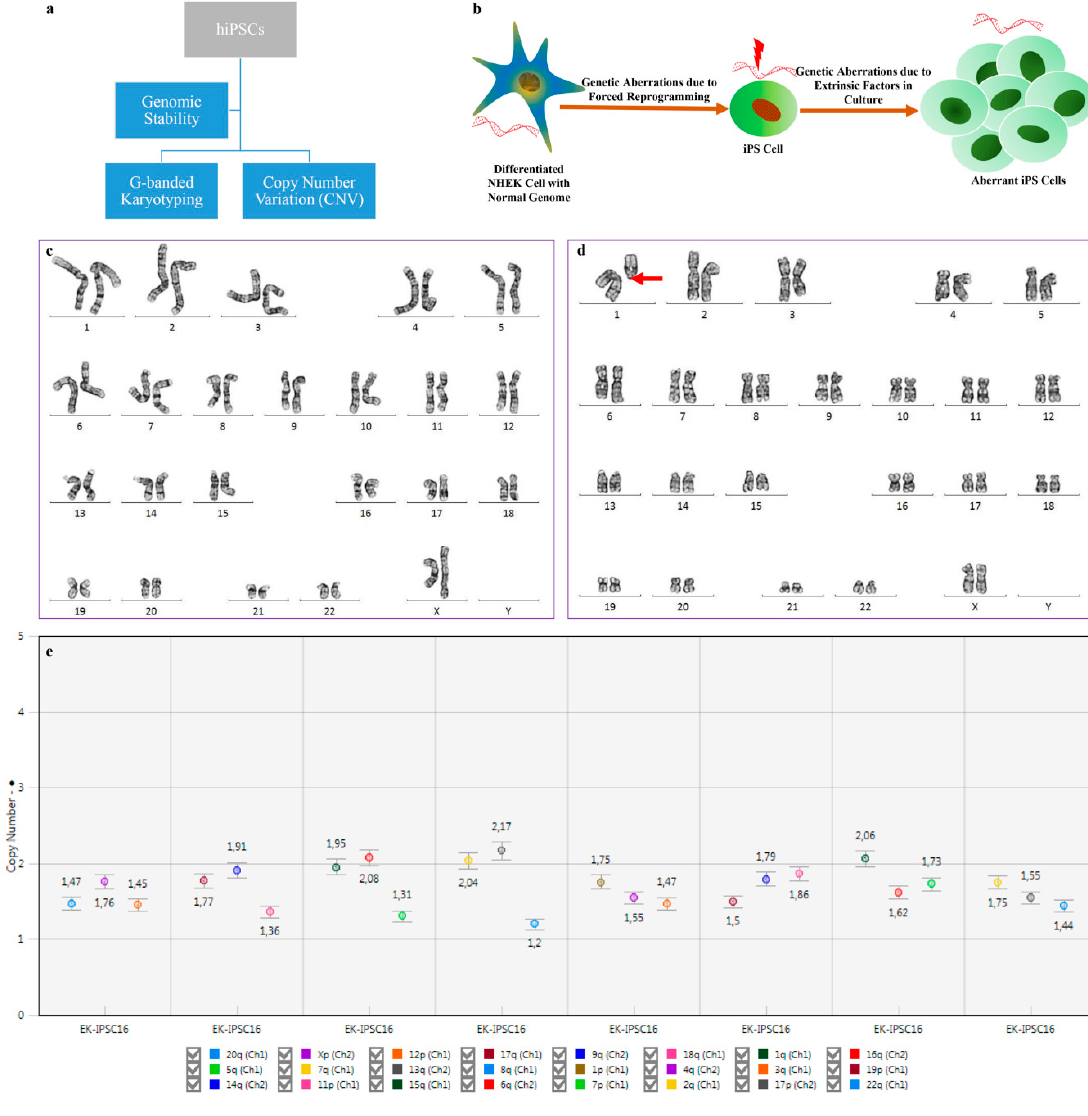
Figure 2. Prolonged culture of hiPSCs causes several genetic alterations that impact applications due to functional consequences. ( a ) Flowchart highlighting the methods for analyzing genomic stability; ( b ) Illustration showing the factors associated with genomic aberrations; ( c ) Cytogenetic analysis showing of normal (46,XX) and ( d ) abnormal (46,XX,del(1)(q11)[cp2]) karyotypes; ( e ) Graph showing the copy number values for 24 probes targeted for specific chromosomes. The legend should be read from the left to the right and line by line. Table 3. Cytogenetic analysis of hiPSCs with chromosomal